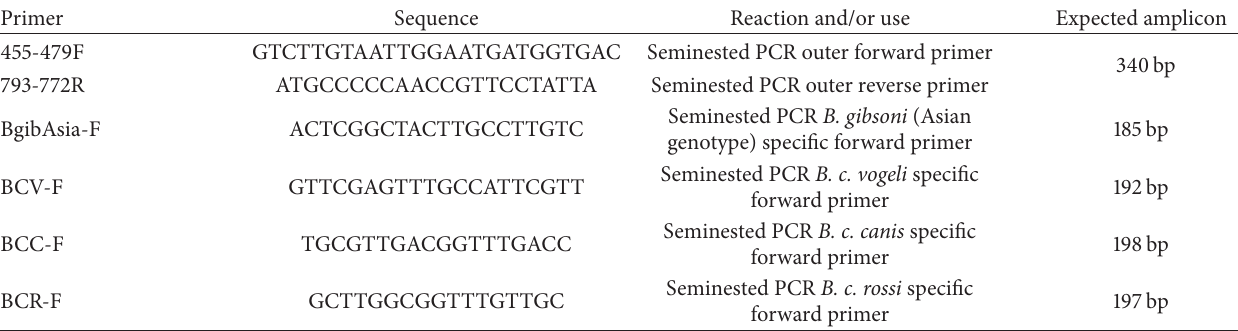
Table 2: Primers sequence for canine babesiosis according to Benson et al., (2002) [27].